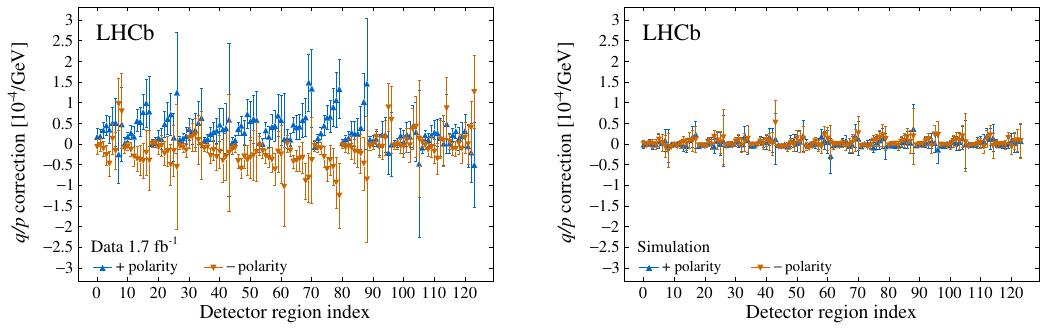
Figure 2 . Curvature corrections as a function of the detector region index (depends on η , φ and tracking detector, as described in the text) for (left) data and (right) simulation. The corrections are shown for both polarity configurations. The periodic pattern corresponds to a dependence on pseudorapidity that repeats in the intervals of the azimuthal